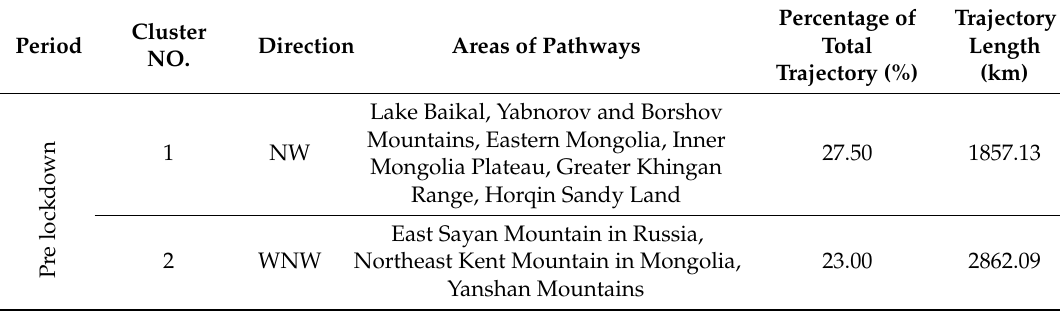
Table 1. Basic information of the clustering trajectory during the preset research